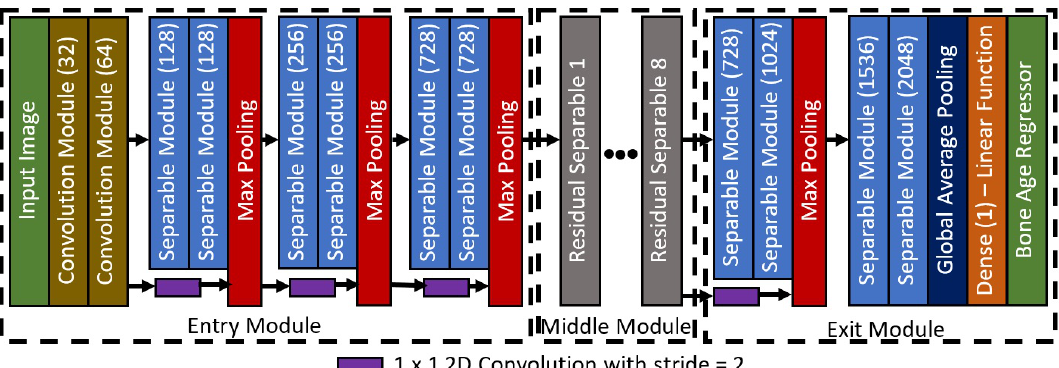
Figure 7. The full architecture of the proposed method with three sub-networks, which are entry, middle, and exit modules. The middle module consists of eight units of residual separable convolution